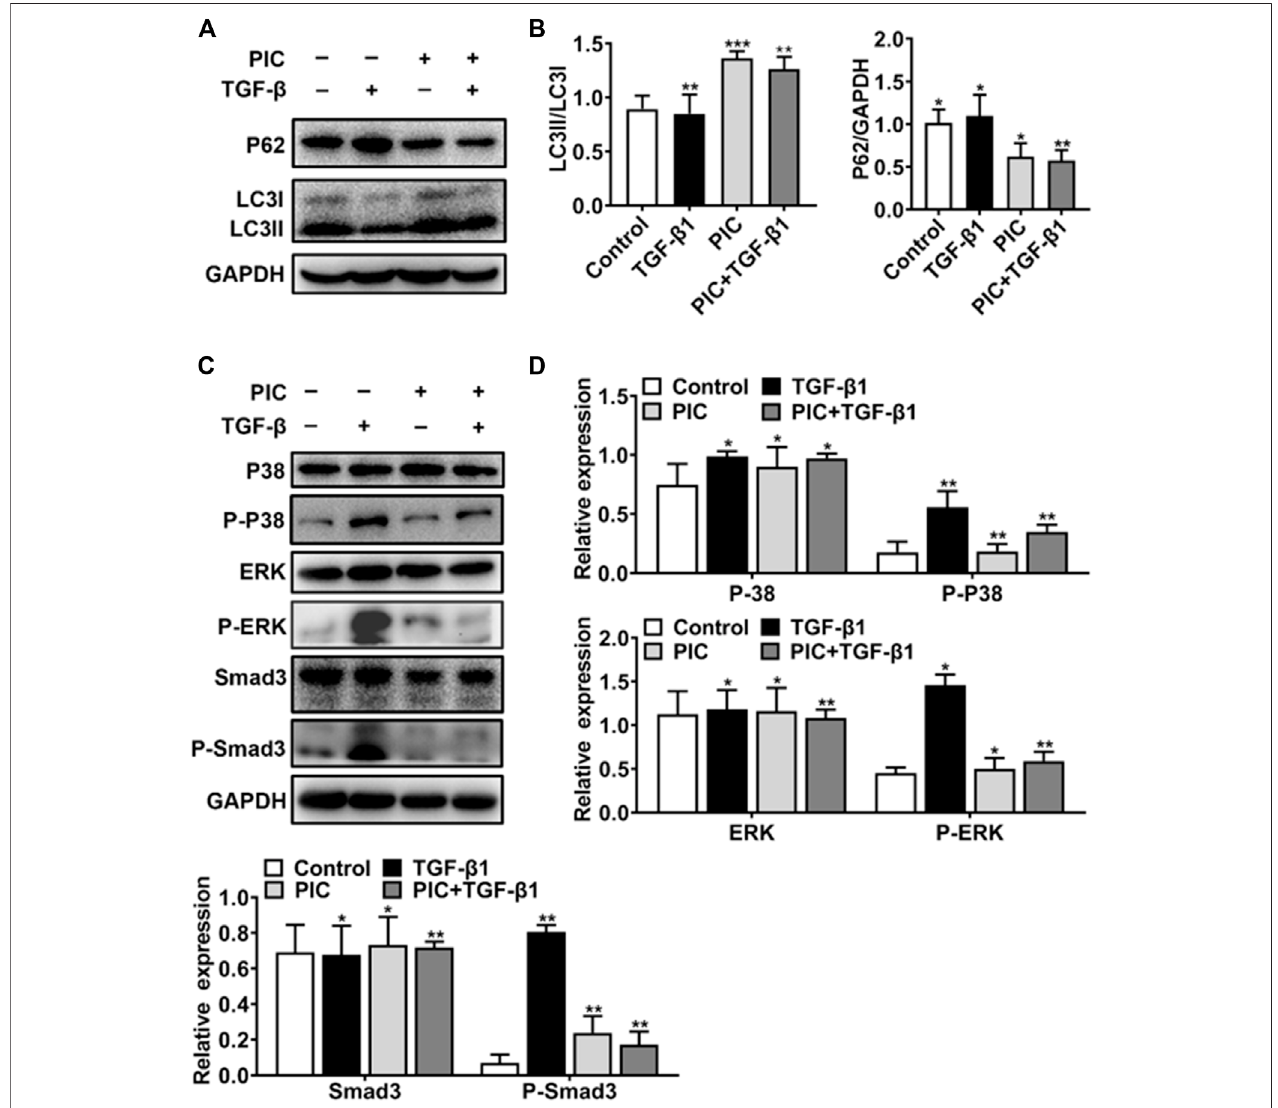
FIGURE 3 | (A) Protein expressions of LC3I, LC3II, P62, and GAPDH in NIH-3T3 cells treated with 5 ng/ml TGF- β 1 with or without PIC (4 μ M) for 24 h (B) QuantitativeWesternblotanalysisof α -SMA,LC3I,LC3II,andGAPDHindifferentgroups. (C) Proteinexpressionsofp-Smad3,Smad3,p-ERK,ERK,P-P38,andP38,in NIH-3T3cellstreatedwith5 ng/mlTGF- β 1withorwithoutPIC(4 μ M)for1 h. (D) QuantitativeWesternblotanalysisofp-Smad3,Smad3,p-ERK,ERK,p-P38,andP38in different groups. Data are expressed as mean ± SD, n = 3. * p < 0.05, ** p < 0.01, and *** p < 0.001.